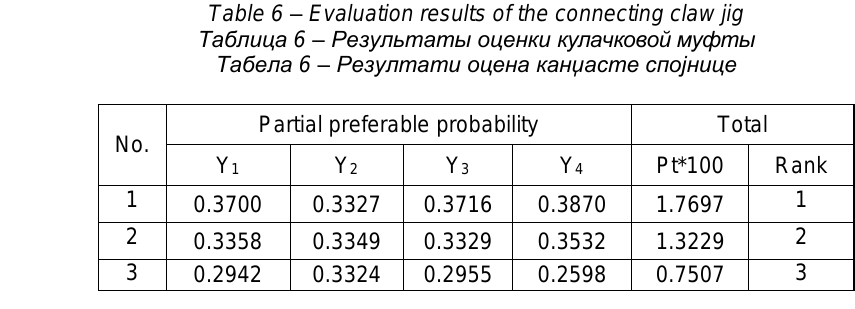
Table 6 – Evaluation results of the connecting claw